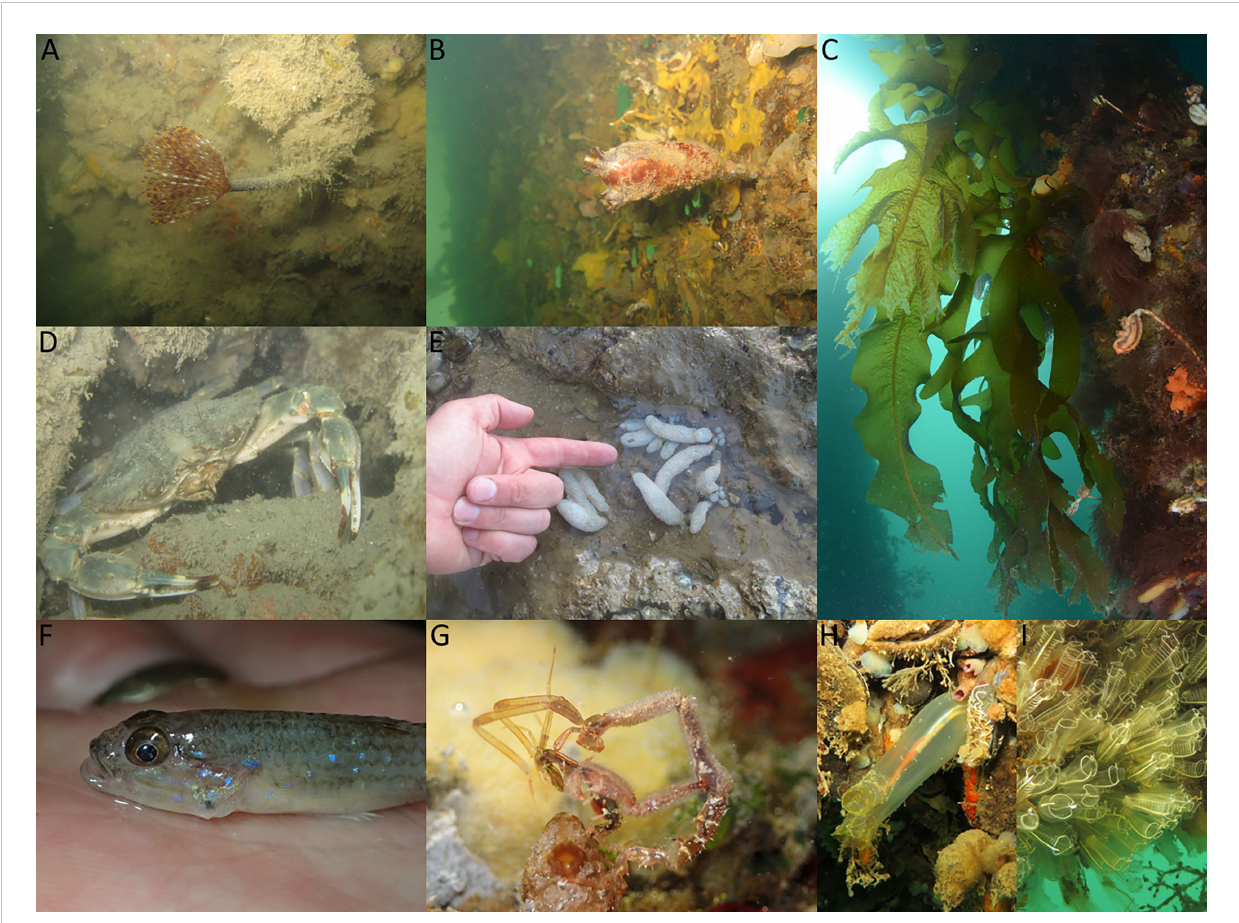
FIGURE 2 Non-indigenous species (NIS) commonly found in New Zealand ports and harbours. Slides include: Sabella spallanzanii (A) ; Styela clava (B) ; Undaria pinnati fi da (C) ; Charybdis (japonica) japonica (D) ; Eudistoma elongata (E) ; Acentrogobius p fl aumii (F) , Caprella mutica (G) ; Ciona intestinalis (H) ; and Clavellina laepadiformis . (I) Photos taken by Crispin Middleton (A, B, D, E) , Chris Woods (F – I) and Leigh Tait (C)